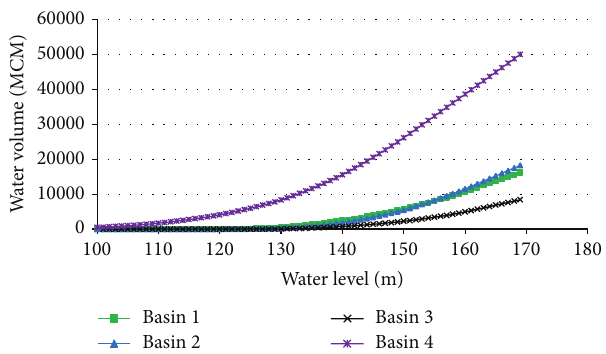
Figure 5: Topographic relation of water volume versus water